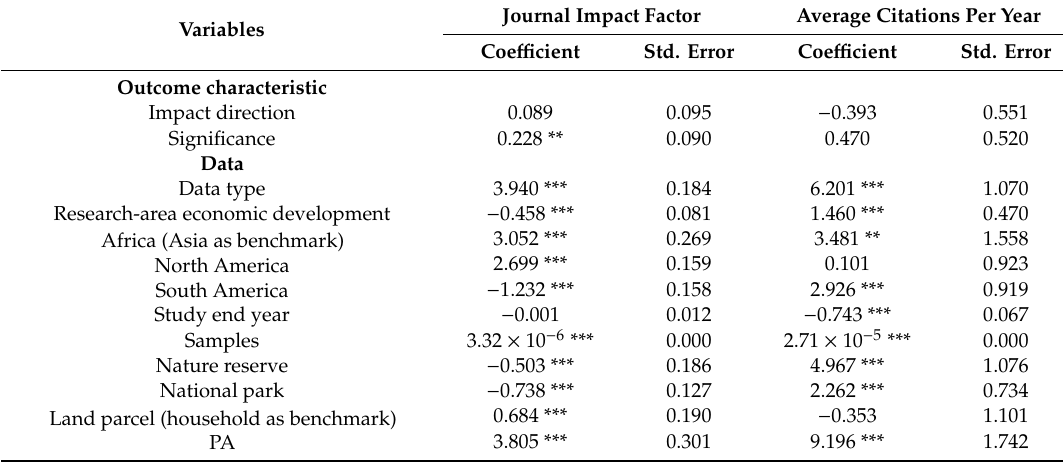
Table 4. Factors a ff ecting a paper’s potential to be published in high-impact journals and the average number of citations per